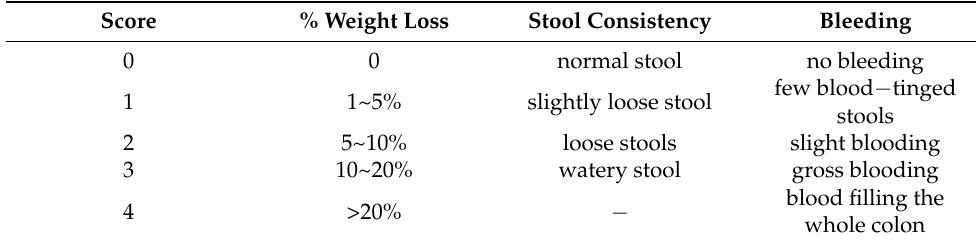
Table 1. Disease activity